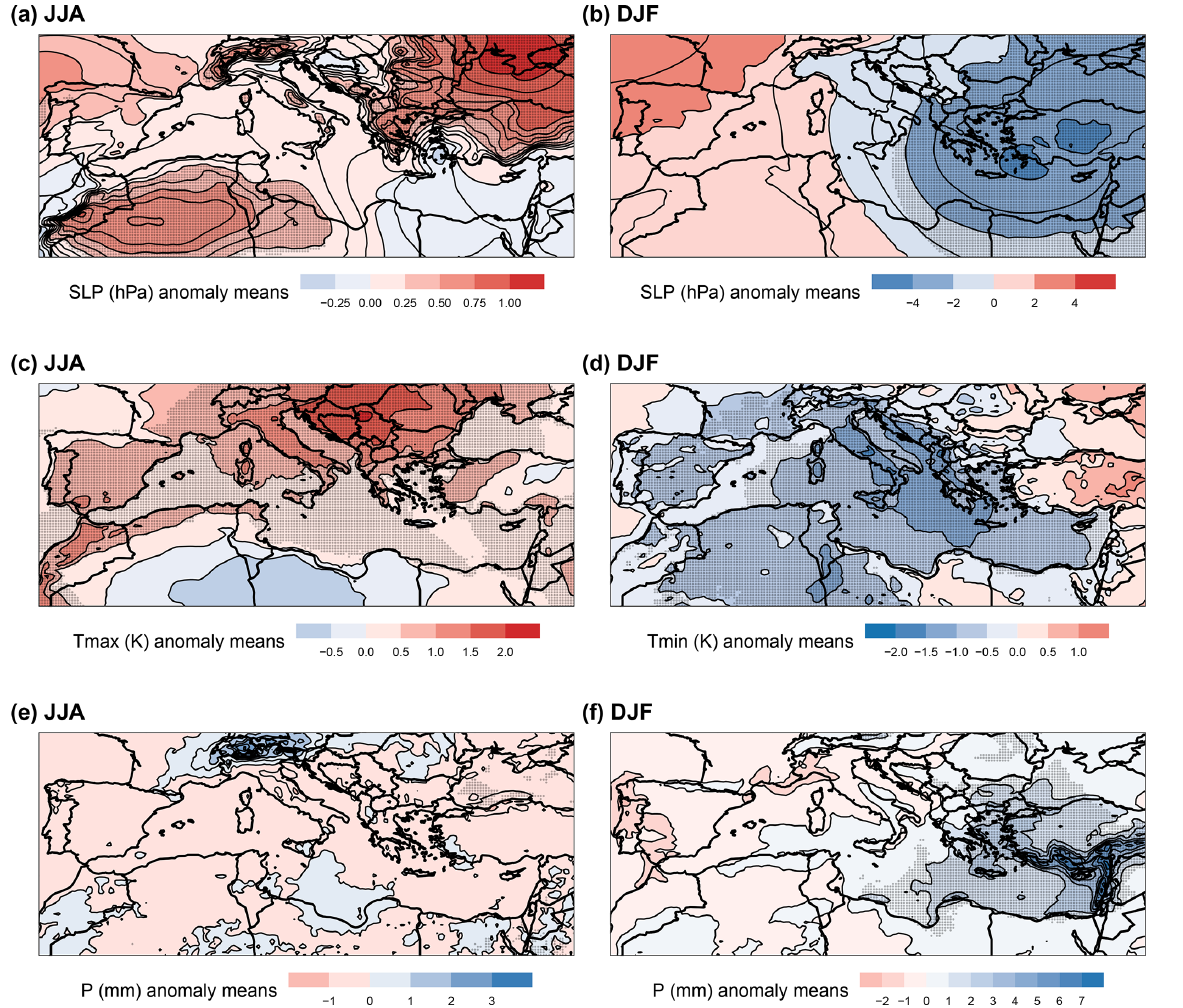
Figure 4. JJA and DJF anomaly means of (a, b) SLP, (c, d) T max and T min , and (e, f) P during CDE days. The data are from the ERA5 reanalysis during 1979–2018. α for JJA is computed from T max and P , whereas that for DJF is computed from T min and P . Stippling shows statistically significant anomalies ( p value < 0.05, Mann–Whitney one-tailed test). The Bonferroni correction is applied to all p